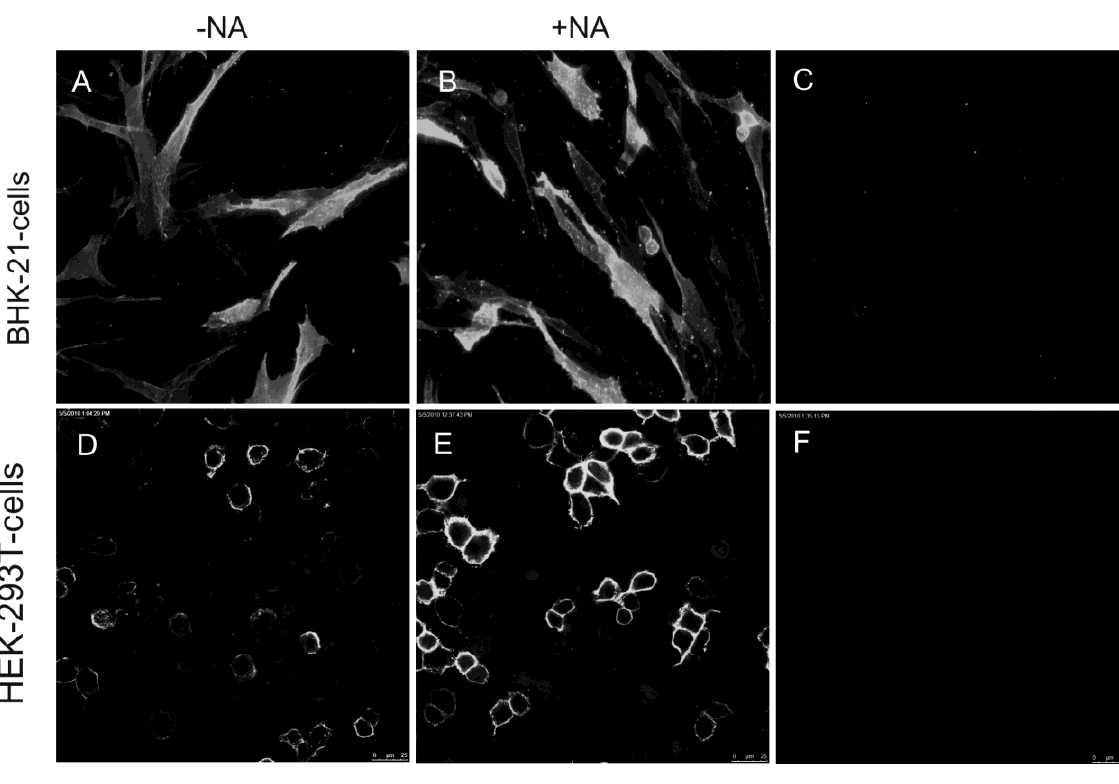
The TGEV spikes bound to cells of non-porcine origin (BHK or HEK-293T cells) only when the cells were transfected with plasmids for expression of the APN receptor. After desialylation of the cells by neuraminidase treatment, the binding was also enhanced (Figure 3). Figure 3. BHK-21 cells and HEK 293T cells were transfected with a plasmid for APN expression (A, B, D, E) and used for binding tests with soluble TGEV spike proteins. Binding was only detectable when porcine APN was expressed (A,B,D,E) and no binding was observed on cells transfected only with empty vector (C,F). A neuraminidase pre- treatment revealed an enhanced binding of the TGEV spike to the cells